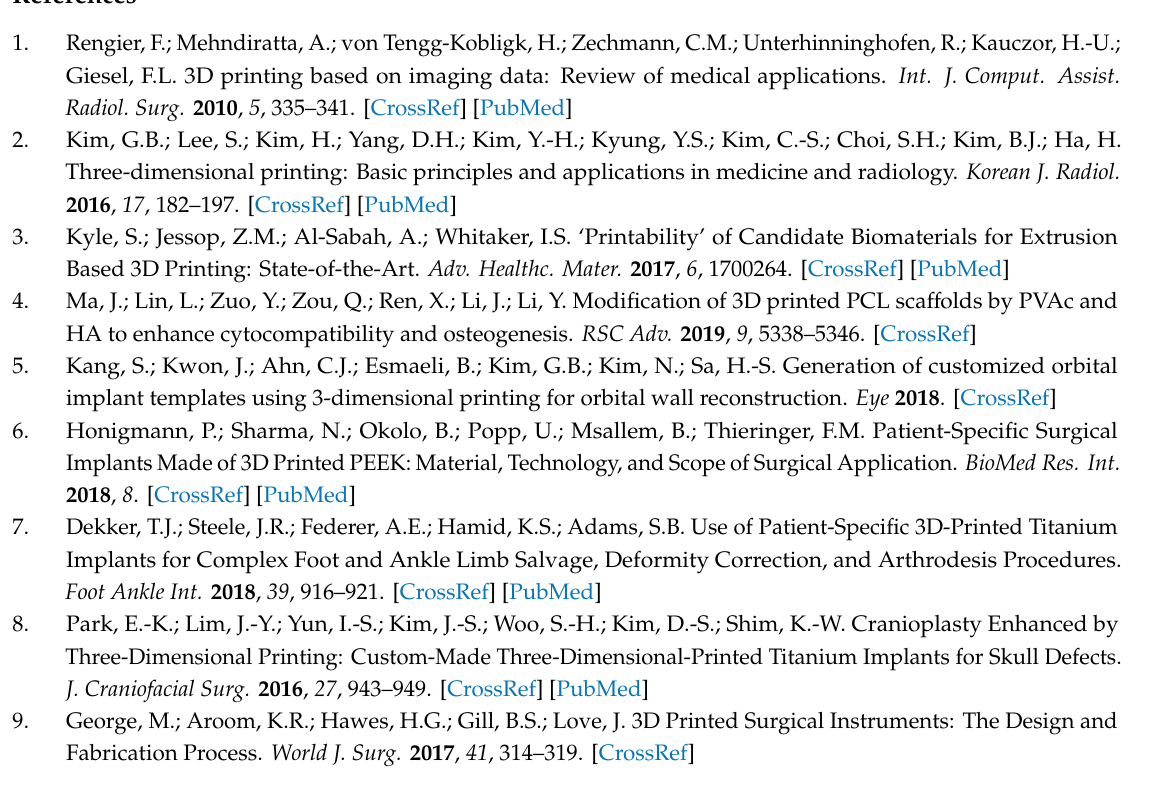
Table S1: Mean and standard deviation of the R-square and RMSE values of the polynomial fitting of the tensile test results of the base materials, Table S2: Mean and standard deviation of the R-square and RMSE values of the polynomial fitting of the tensile test results of the specimens with embedded patterns, Table S3: Mean and standard deviation of the R-square and RMSE values from the polynomial fitting of the tensile test results of the patterned TPU 95A specimens, Figure S1: Mean stress-strain curves of the Agilus–VeroCyan specimens with the 0.7 mm embedded patterns, Figure S2: Mean stress-strain curves of the Dragonskin 30–TPU 95A specimens with the 0.7 mm embedded patterns, Figure S3: Mean stress-strain curves of the Agilus–VeroCyan specimens with the 1.4 mm embedded patterns, Figure S4: Mean stress-strain curves of the Dragonskin 30–TPU 95A specimens with the 1.4 mm embedded patterns, Figure S5: Mean stress-strain curves of the TPU 95A specimens with the 0.7 mm embedded patterns, Figure S6: Mean stress-strain curves of the TPU 95A specimens with the 1.4 mm patterns, Figure S7: Modulus of elasticity of the Agilus–VeroCyan specimens with the 0.7 mm embedded patterns, Figure S8: Modulus of elasticity of the Dragonskin 30–TPU 95A specimens with the 0.7 mm embedded patterns, Figure S9: Modulus of elasticity of the Agilus–VeroCyan specimens with the 1.4 mm embedded patterns, Figure S10: Modulus of elasticity of the Dragonskin 30–TPU 95A specimens with the 1.4 mm embedded patterns, Figure S11: Modulus of elasticity of the TPU 95A specimens with the 0.7 mm embedded patterns, Figure S12: Modulus of elasticity of the TPU 95A specimens with the 1.4 mm